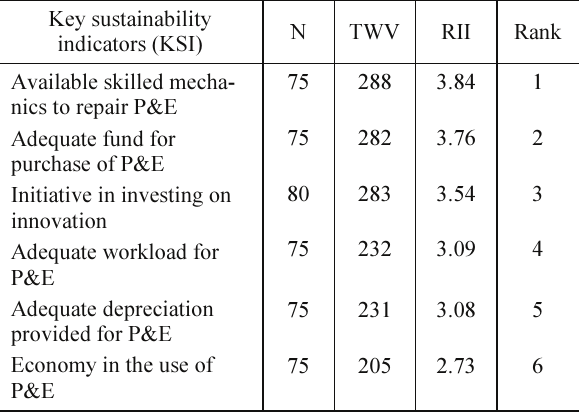
Table 7. Level of sustainability of concrete